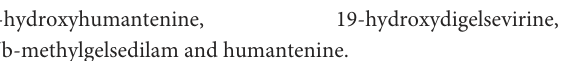
6-hydroxyhumantenine, 19-hydroxydigelsevirine, Nb-methylgelsedilam and